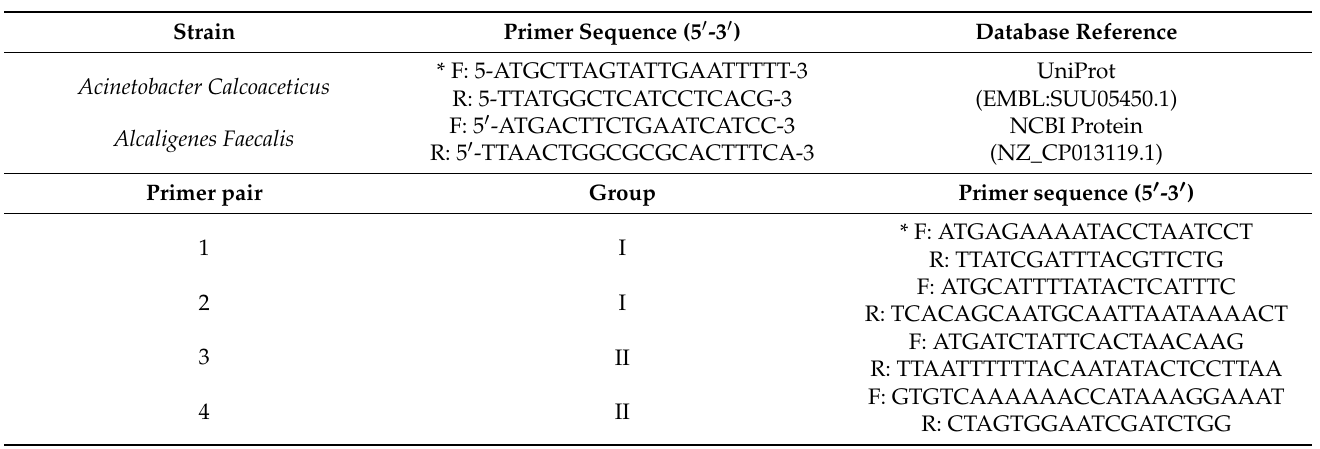
Table 1. Primers for phaC amplification in isolated strains. Primers for phaC amplification in Sphingob- acterium mizutaii were designed by protein-based indirect speculation of the possible nucleic acid sequences